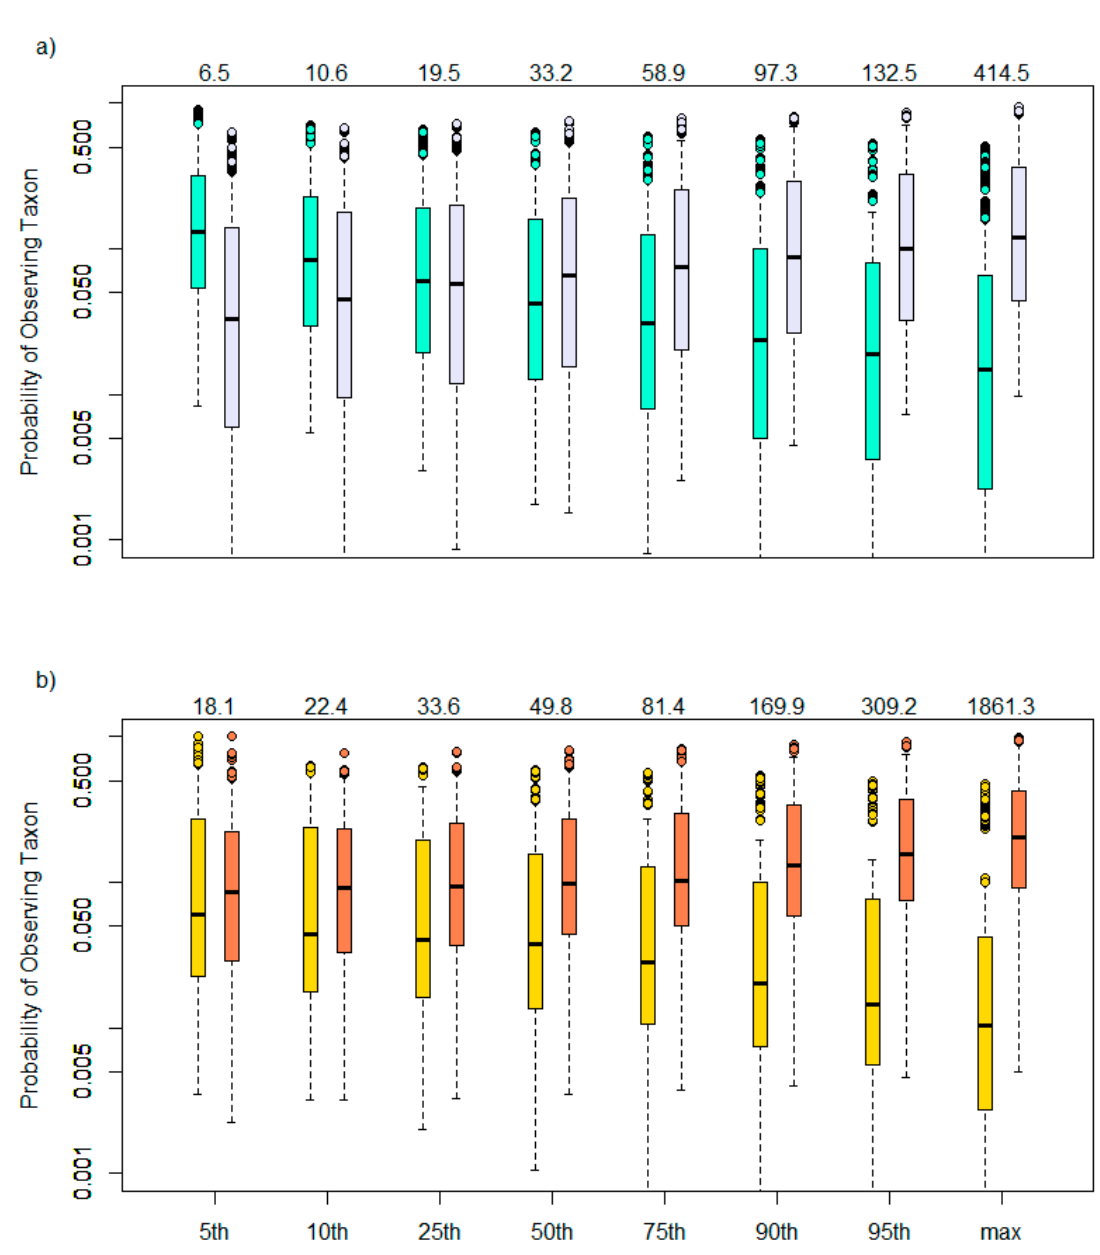
Figure 4. Distributions of taxa observation probabilities (y-axes) from logistic regression plotted by quantile intervals (e.g., <5th, 5th–10th, etc.); concentrations for the stated quantiles are arrayed across the top margins. ( a ) Probabilities for chloride where taxa having decreasing slopes are shown in light green, and those with increasing slopes in light purple. For reference, the HC5 from the species sensitivity distribution constructed from statewide data is 52 mg/L. The chronic continuous concentration (CCC) published by US EPA [36] is 230 mg/L. ( b ) Probabilities for sulfate where taxa having decreasing slopes are shown in yellow and those with increasing slopes are shown in orange. For reference, the HC5 from the species sensitivity distribution constructed from the WAP subset is 152 mg/L, and the HC5 from the statewide SSD was 94 mg/L. The Criterion Maximum Concentration (CMC) from the Illinois toxicity model [37] would default in many cases to 500 mg/L for Western Allegheny Plateau headwaters because of high levels of hardness associated with mine drainage. Note that acute to chronic ratios are typically ~10 [40].